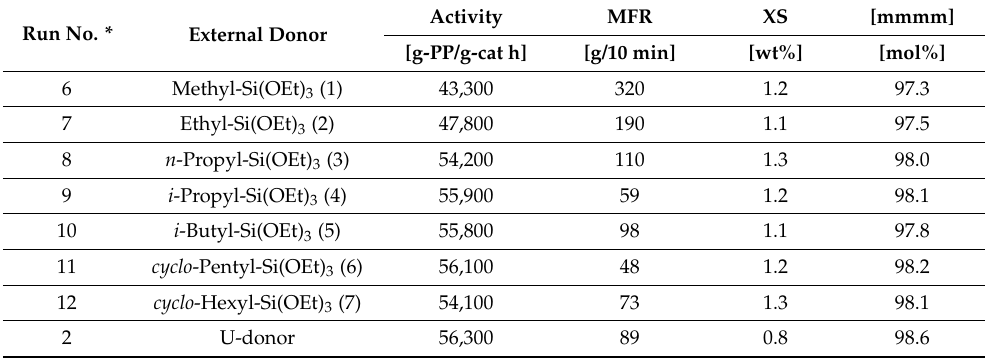
Table 2. External donors of triethoxyalkylsilanes ( 1 – 7 ) propylene polymerization screening against U-donor.